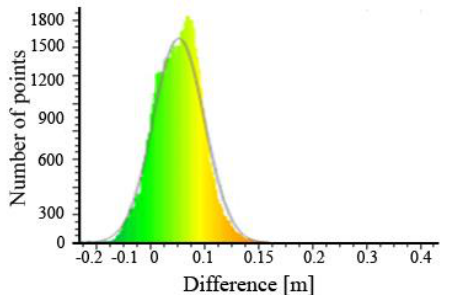
Figure 21. A graph showing a distribution of the cloud deviations of Test Area No.